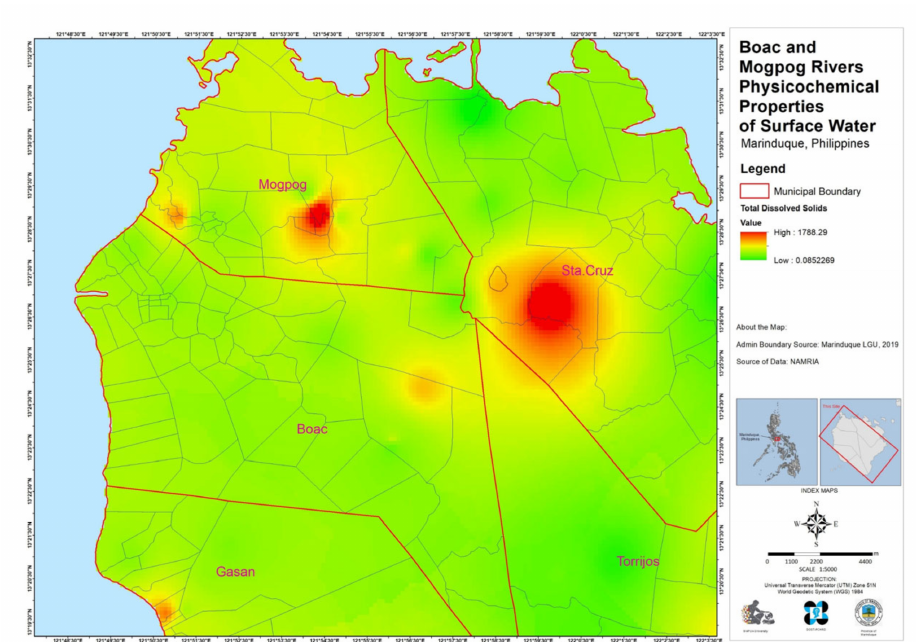
Figure A3. Spatial Map for